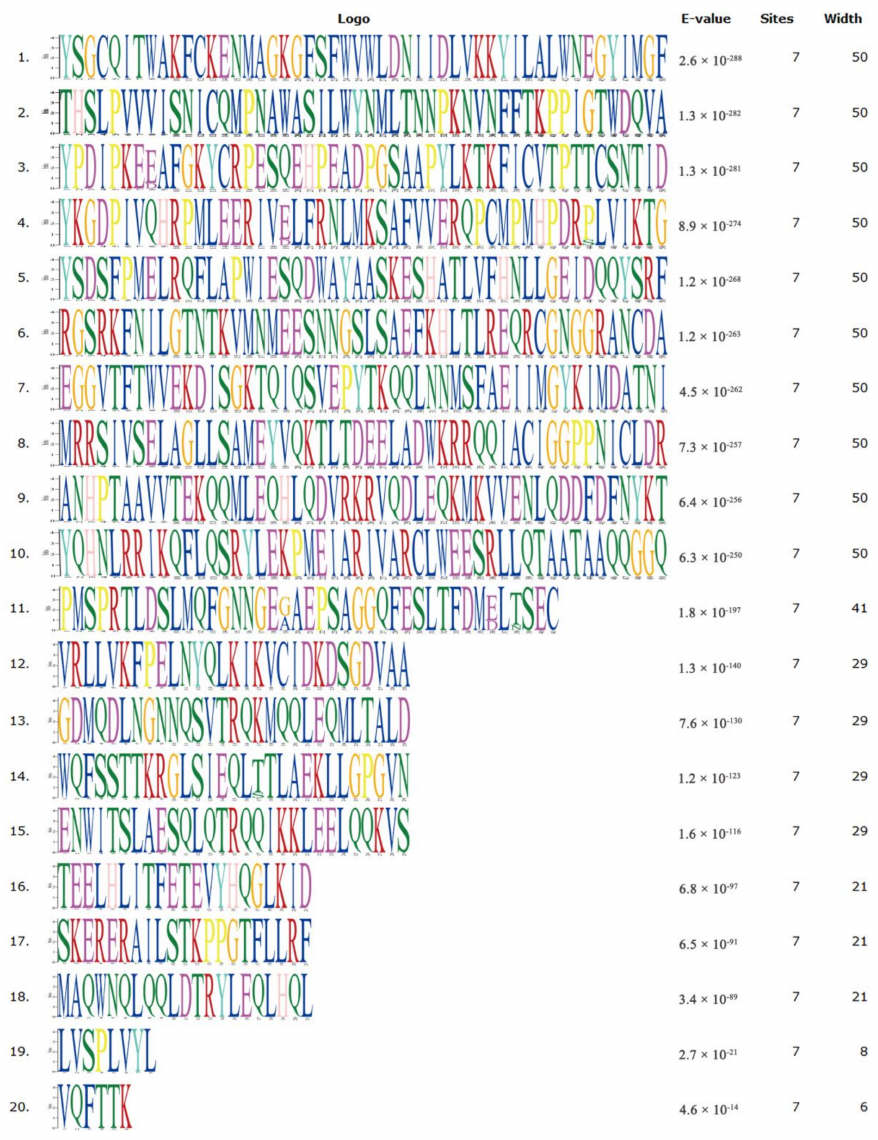
Figure 3. Significant STAT3 motifs across the seven tested species, detected using the MEME suite. The different color letters show abbreviation of different amino acids. These colors are given through motif analysis performed through MEME suit system.